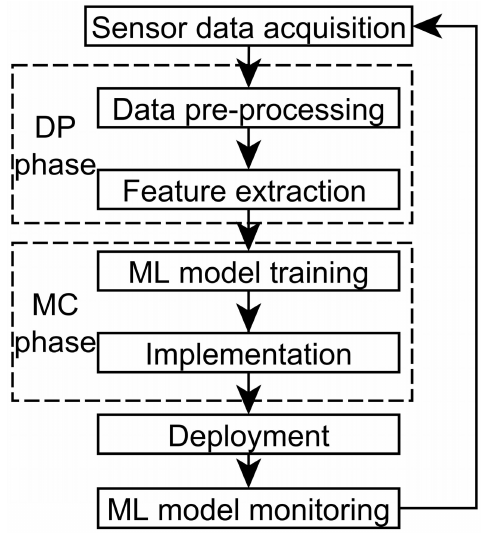
Figure 1. A basic life cycle of an ML sensor